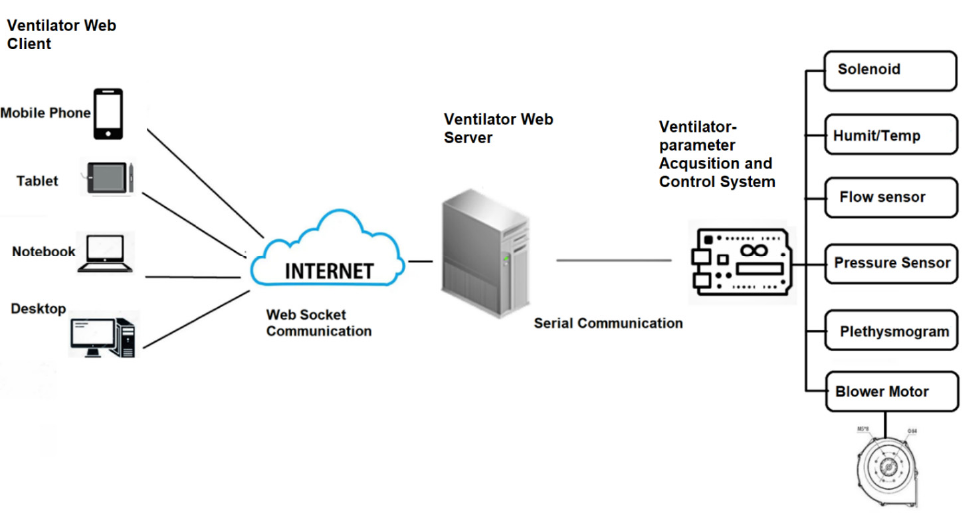
Figure 7. Ventilator server for remote control and monitoring. Caretaker can remotely access via mobile phone, tablet, notebook or desktop by Web Socket communication. Webserver can interface with sensor and actuator by UART communication.